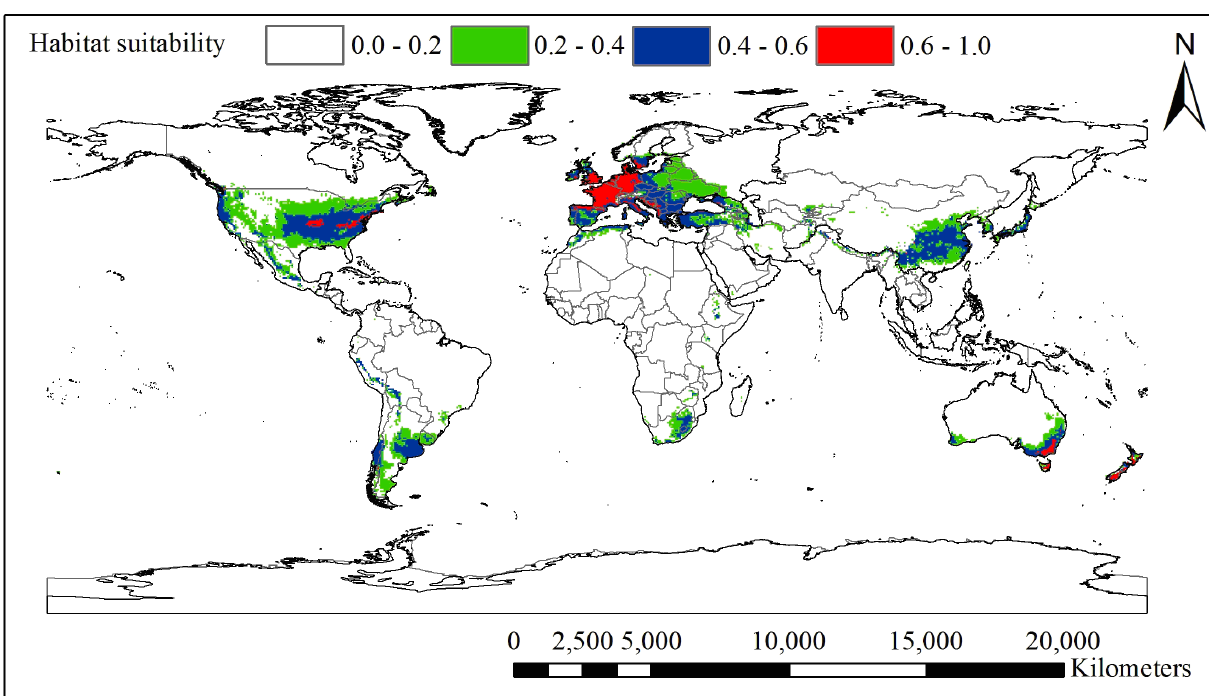
Figure 2. Global potential distribution area of black locust predicted by the MaxEnt model around the world (the grid cell is 0.5° × 0.5°); the value of climatic suitability is the average of a ten-fold cross-validation. The standard deviation of each grid square is